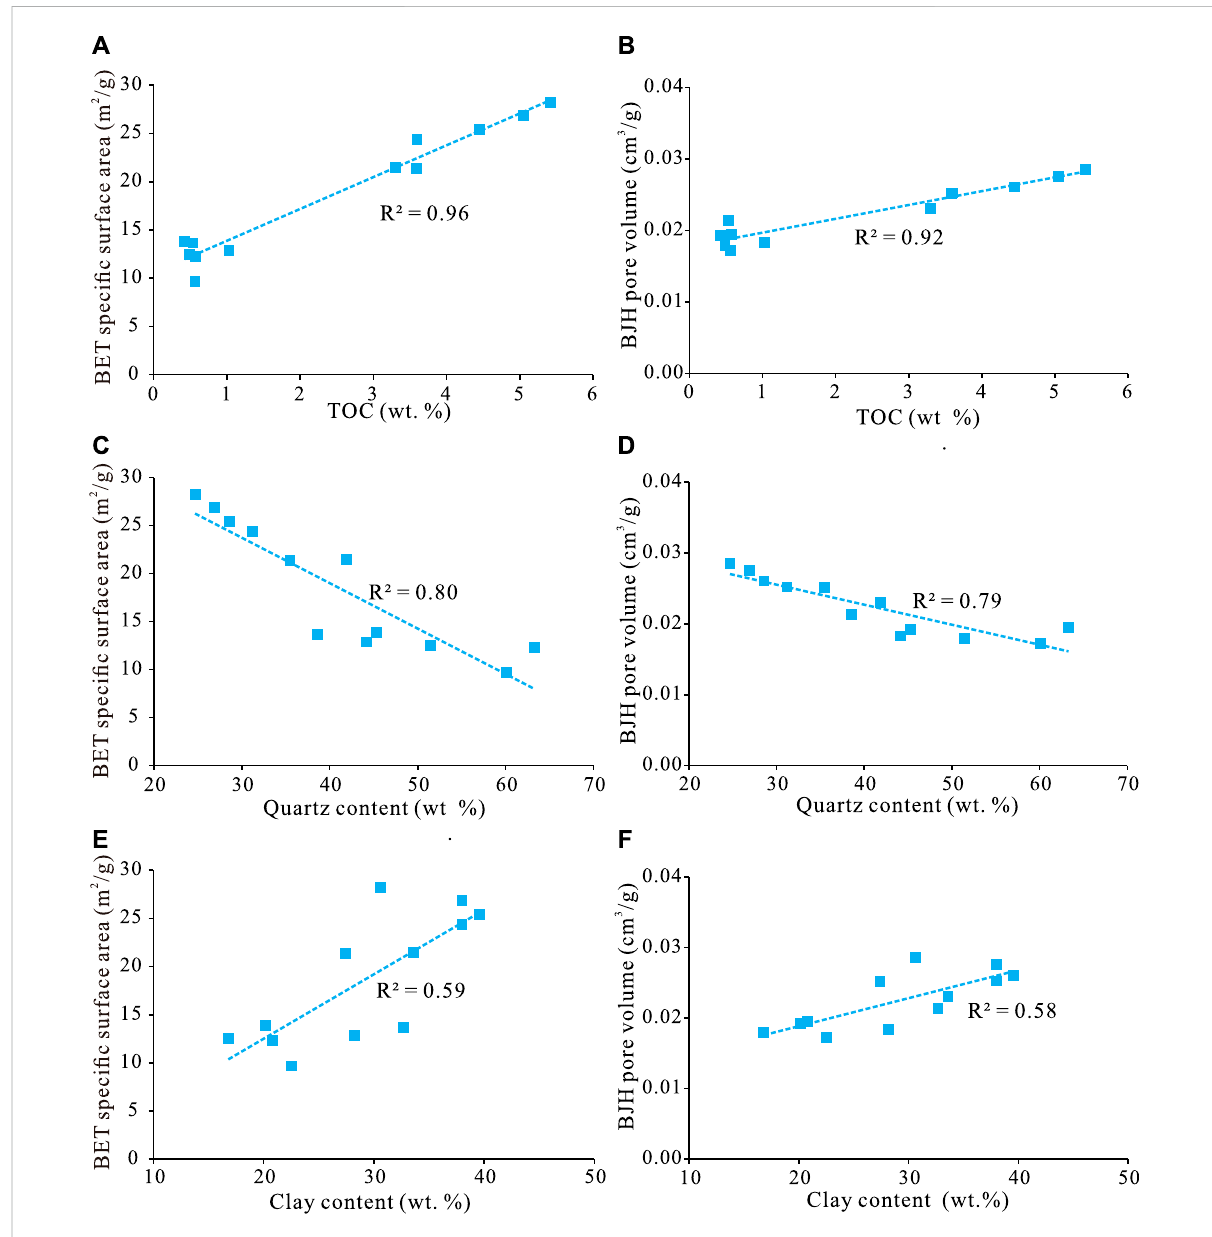
FIGURE 11 Relationships between pore structure parameters and shale composition [ (A) TOC vs BET SSA, (B) TOC vs BJH PV; (C) quartz content vs BET SSA; (D) quartz content vs BJH PV; (E) clay content vs BET SSA, (F) clay content vs BJH PV].